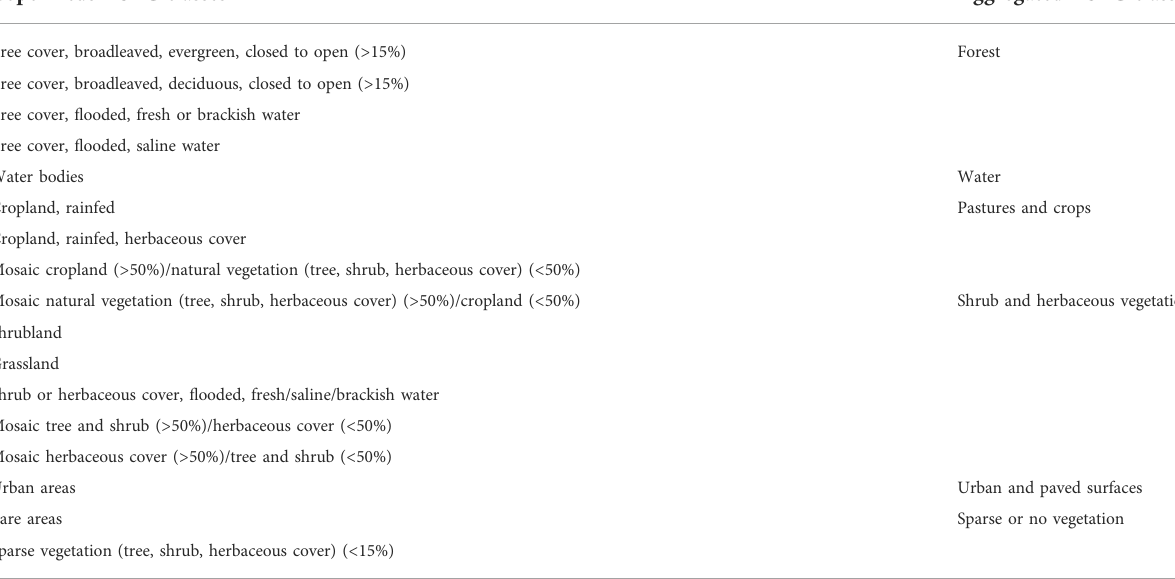
TABLE 1 ESA LC CCI land use and land cover classes (LULC; left column) and aggregated LULC classes in this work (right column). Copernicus LULC classes